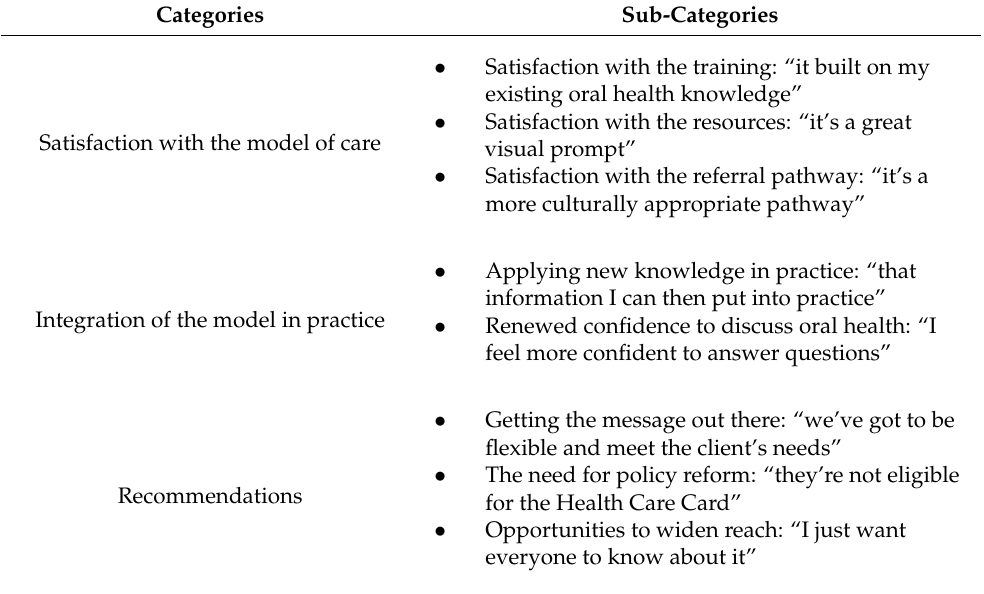
Table 1. Categories and